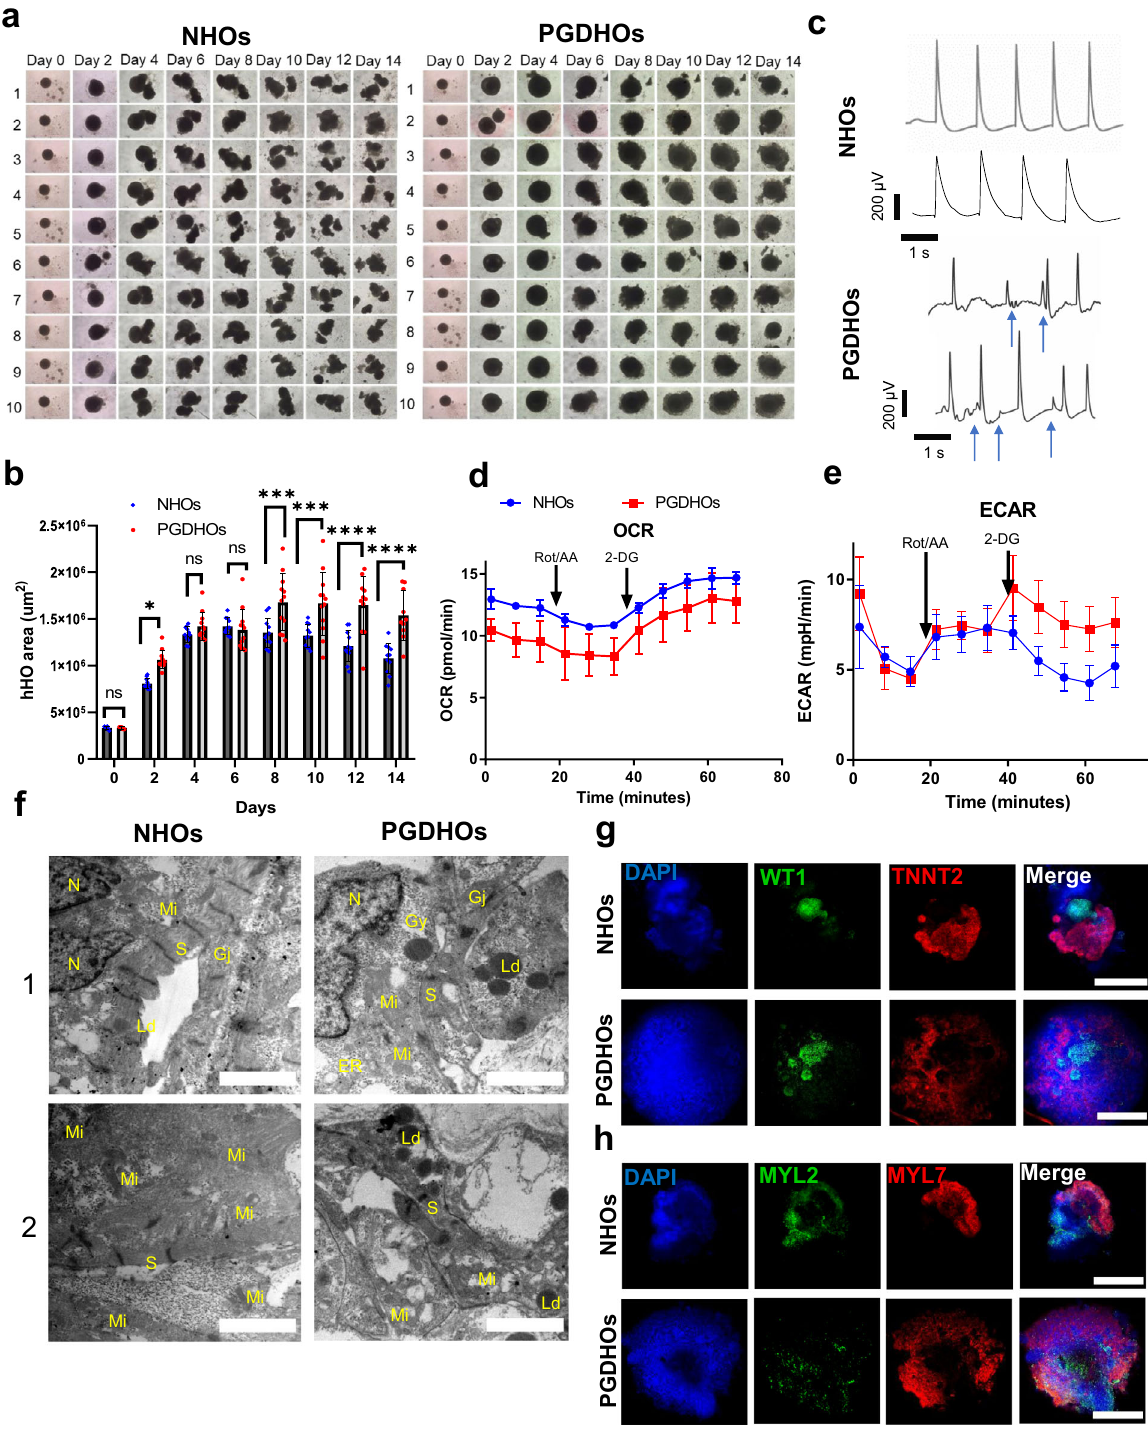
tissue on top of or beside myocardial tissue as physiologically expected (Fig. 7h). These impairments in structural/developmental organization and lipid metabolism in PGDHOs are consistent with expected phenotypes found in PGD-induced CHD. Taken together, our data suggest signi fi cant molecular and metabolic perturbations between NHOs and PGDHOs consistent with previous studies on PGD suggesting increased oxidative stress, cardiomyopathy, and altered lipid pro fi les 48 – 50 , constituting a signi fi cant step forward towards modeling metabolic disorders in human